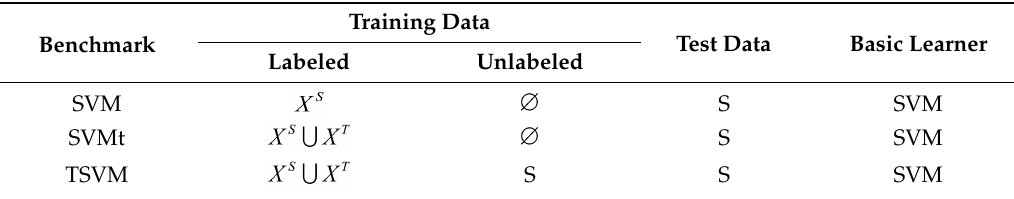
Table 3. The descriptions of baseline methods.